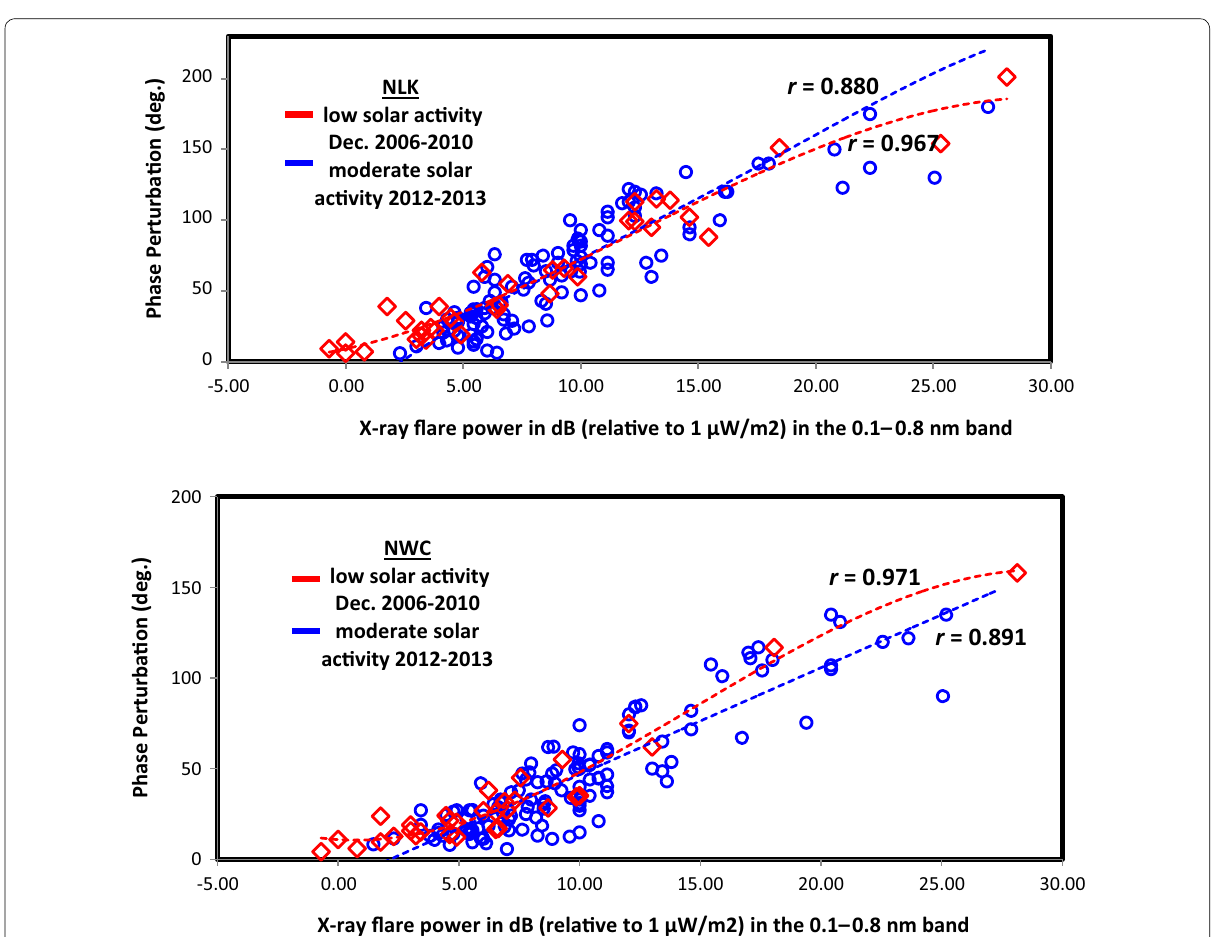
Fig. 5 VLF phase perturbations for NLK and NWC measured at Suva, Fiji, as functions of solar flare X-ray flux measured in dB relative to 1 µW/m 2 in the 0.1–0.8 nm band, for low-solar activity conditions (red points and corresponding red best-fit curves) and moderate-solar activity conditions (blue points and corresponding blue best-fit curves)